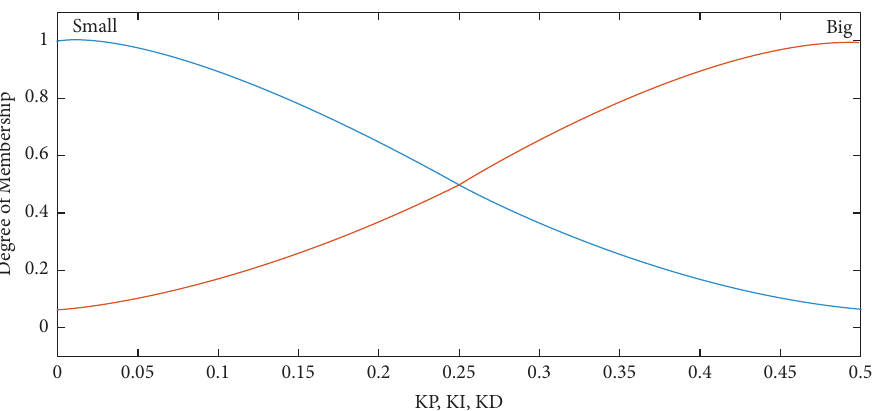
Figure 12: Outputs Δ K